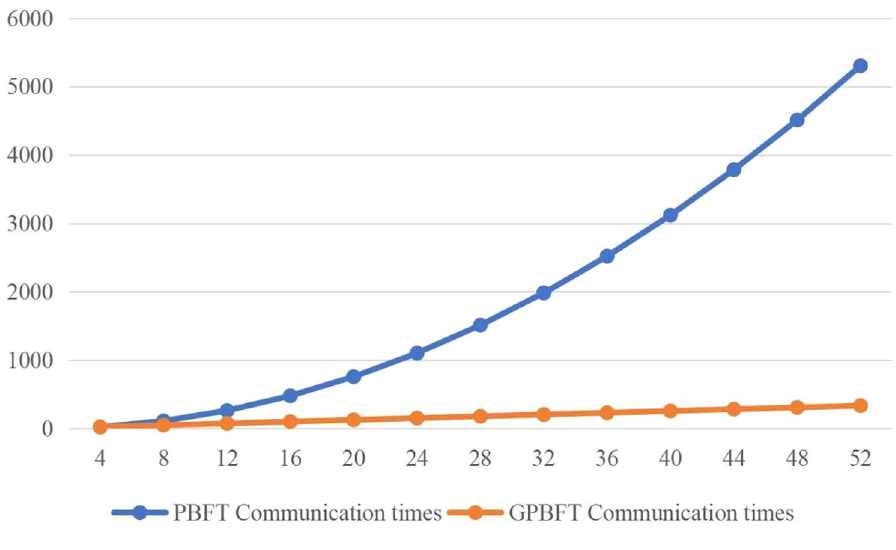
Figure 4. PBFT algorithm vs. GPBFT algorithm communication